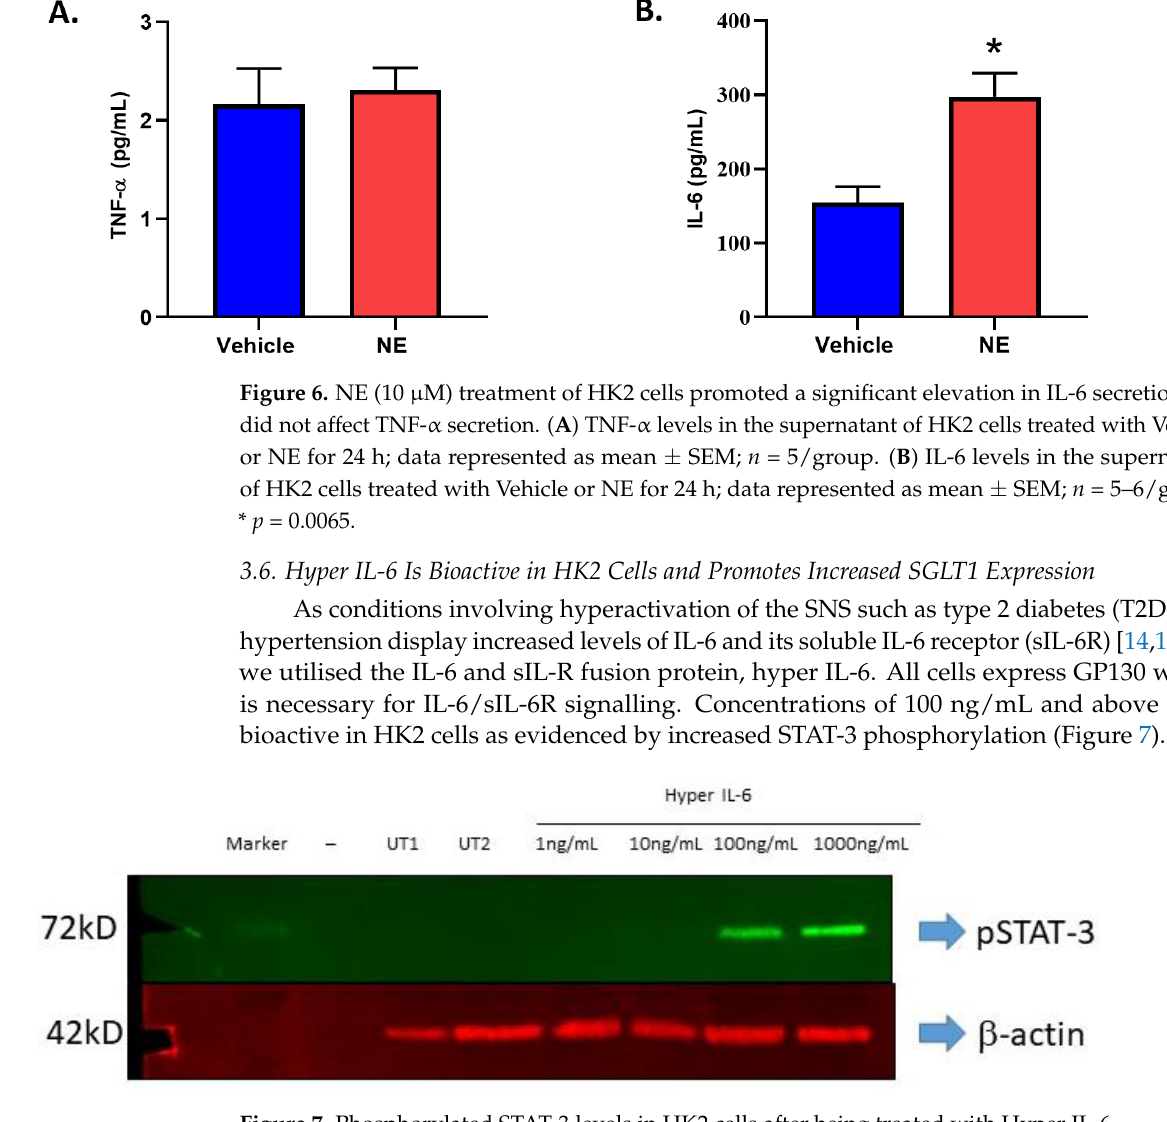
Figure 7. Phosphorylated STAT-3 levels in HK2 cells after being treated with Hyper IL-6.